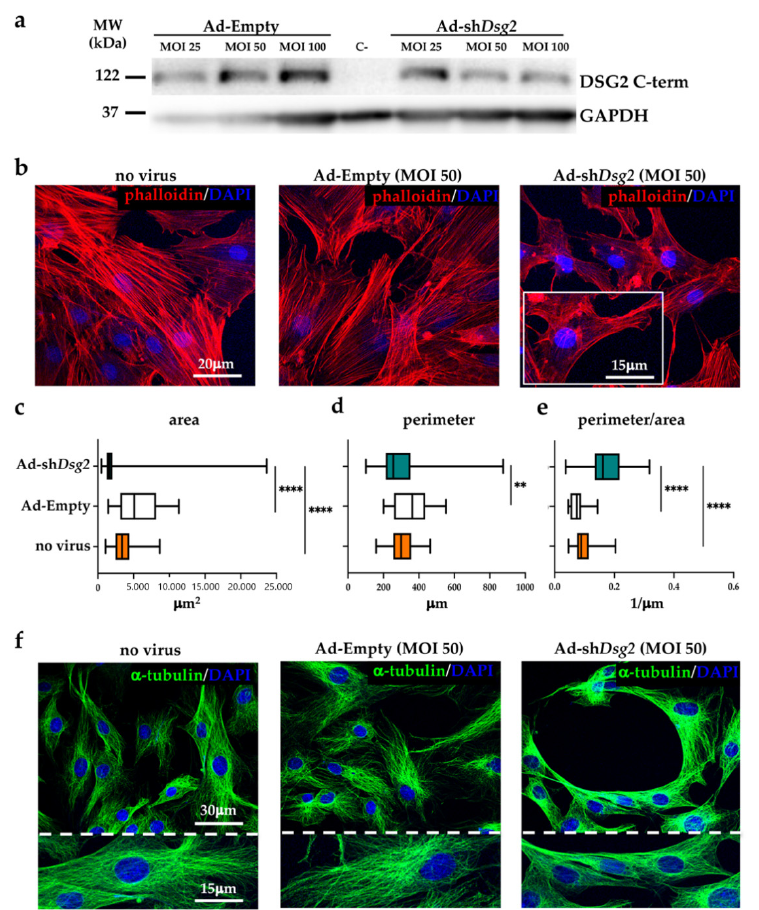
Figure 5. DSG2-downregulated bone marrow mesenchymal stromal cells display altered cytoskeletal organization. ( a ) Western blotting on protein extracts from cultured rat BM-MSCs transduced with either Ad-Empty or Ad-sh Dsg2 at different MOI (25, 50, and 100). GAPDH was used to ensure equal protein loading. MW, molecular weight. C-, negative control ( Dsg2 mut/mut heart). ( b ) Confocal IF analysis of cultured rat BM-MSCs infected with Ad-Empty (MOI 50) or Ad-sh Dsg2 (MOI 50). Cells were stained with AlexaFLUOR ® -568 conjugated phalloidin (red signal). Nuclei were counterstained with DAPI (blue signal). ( c – e ) Morphometric evaluation of cell surface, perimeter, and perimeter/area ratio in cultured rat BM-MSCs shown in ( b ). A total of 25 cells for each study group were analyzed. Whiskers represent min to max values. ** p ≤ 0.01; **** p ≤ 0.0001. ( f ) Confocal IF analysis of cultured rat BM-MSCs infected with Ad-Empty (MOI 50) and Ad-sh Dsg2 (MOI 50). Cells were stained with anti- α -tubulin antibody (green signal). Nuclei were counterstained with DAPI (blue signal).